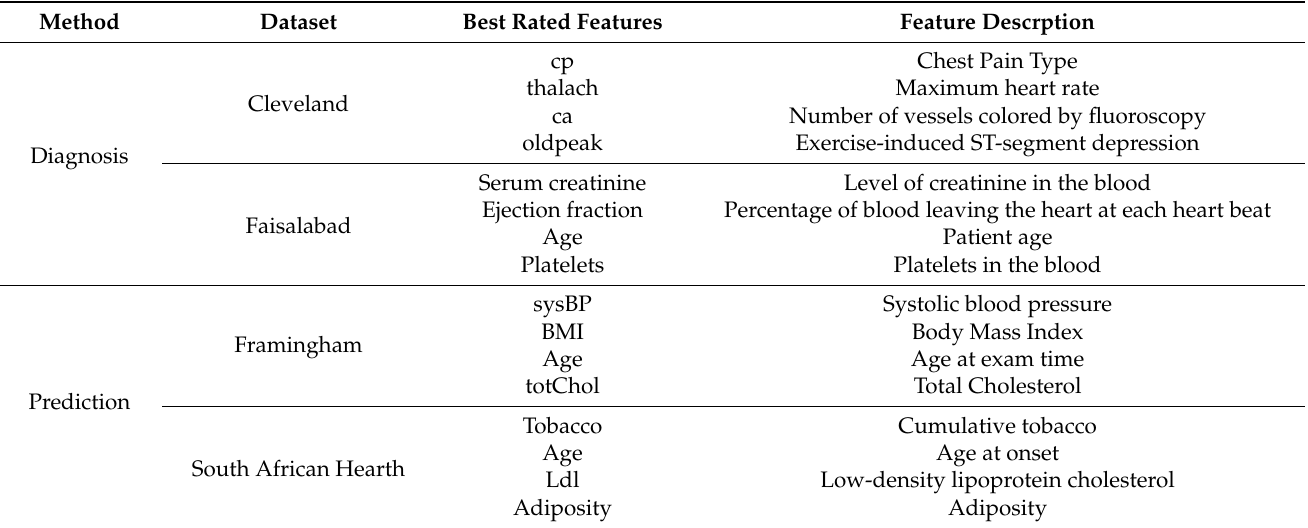
Table 11. Main risk factors for CVD diagnosis and